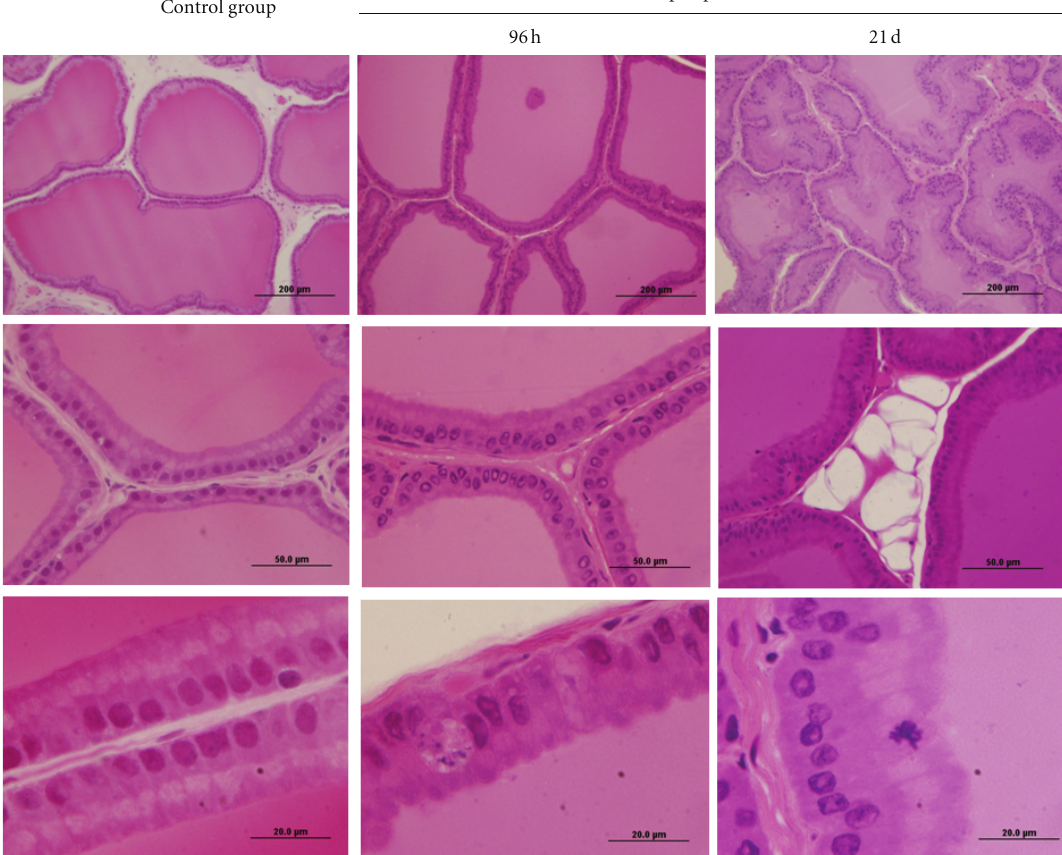
Figure 3: Haematoxylin and eosin stained histological sections of rat ventral prostatic tissue under di ff erent conditions of sleep deprivation. The prostate of control group shows the acini (Ac) with great amount of secretion in the luminal region (Lu), and the epithelium (Ep) is visualized with conspicuous Golgi’s region (star), indicative of high secretion activity. During the sleep deprivation conditions, the acini compartment is decreased, and the presence of unilocular adipose tissue is evident ( ∗ ). The thin arrow indicates an apoptotic body in the epithelium. Stroma